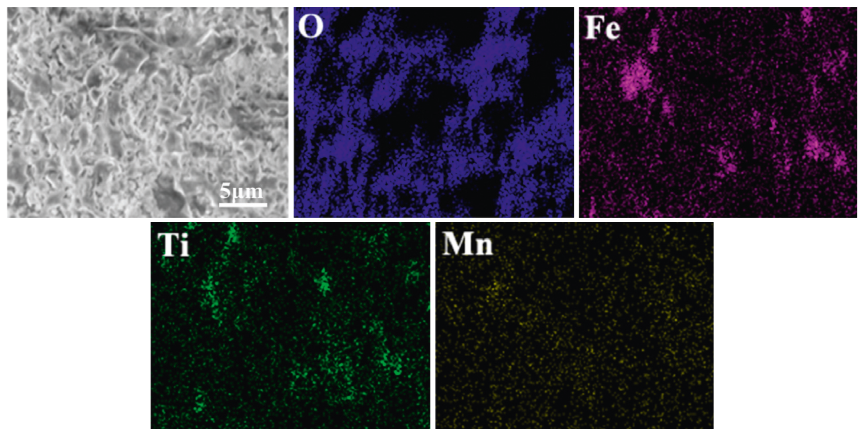
Figure 8: Element distribution of ceramics with 15% vanadium-titanium slags at the sintering temperature of 1100 ° C.